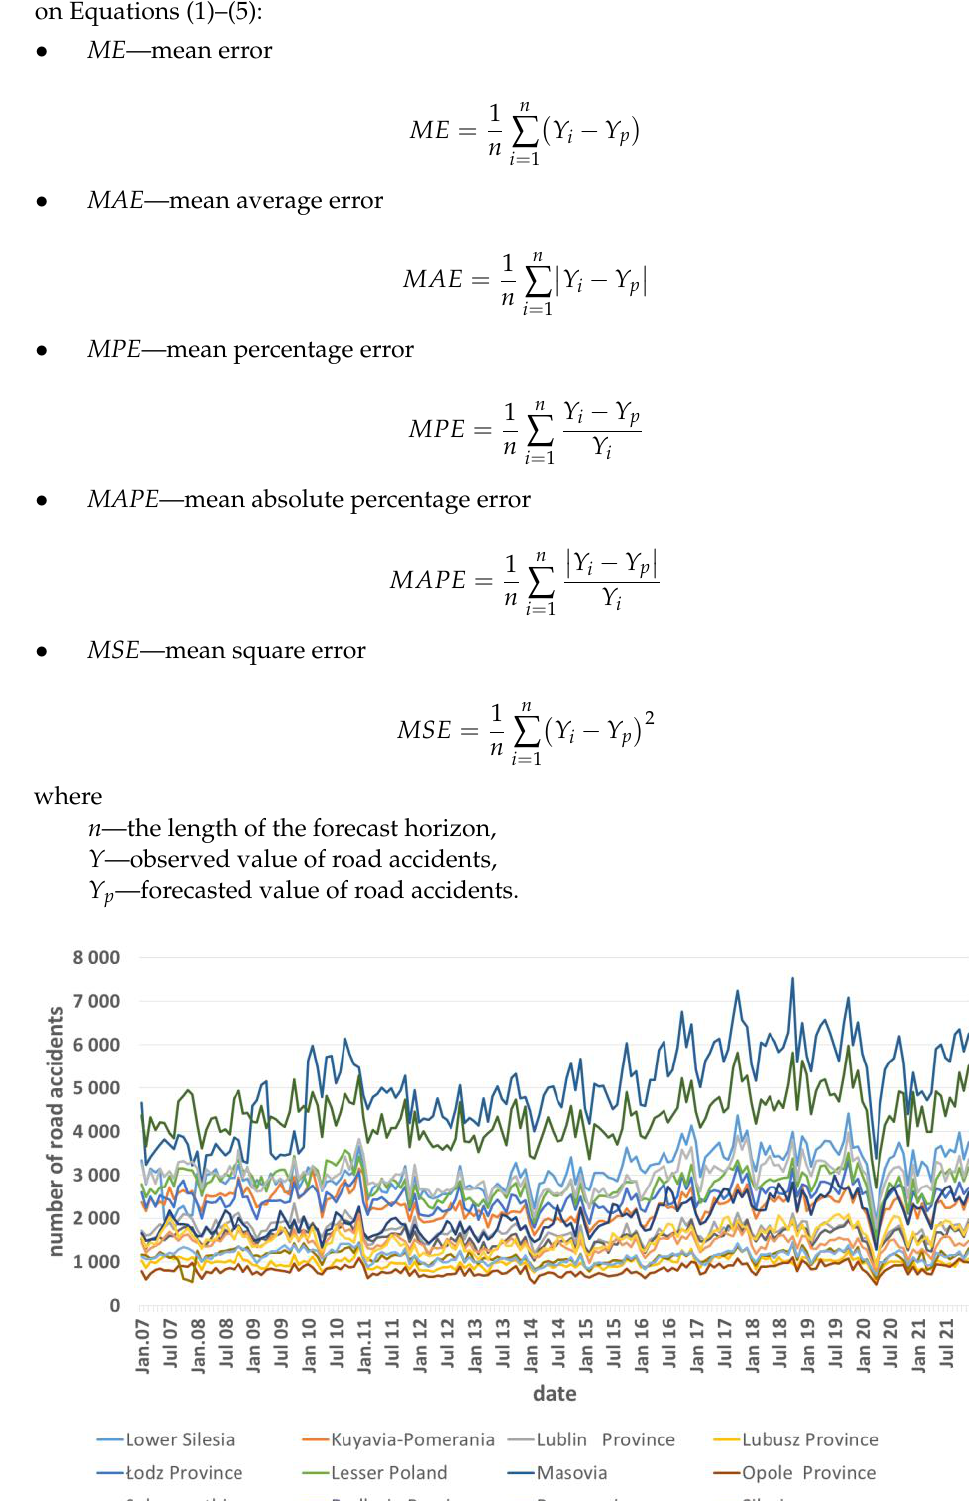
Figure 5. Number of road accidents in Poland by province from 2007 to 2021 [60].